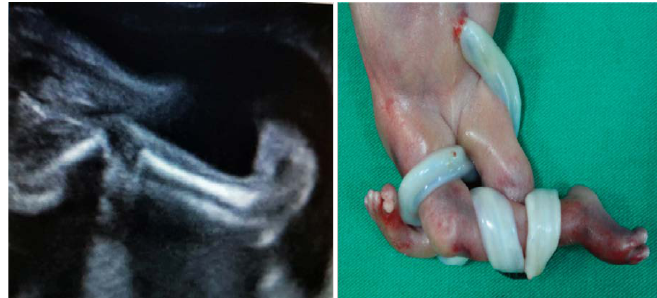
Figure 4. Fetal arthrogryposis with talipes (collection of Filantropia Hospital).